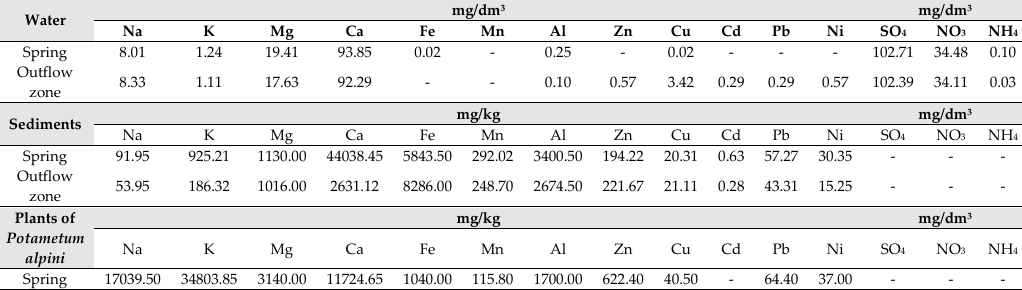
Figure 6. Ratio of water macroelement concentrations in the water source zone to those in the outflow zone. Table 2. Chemical parameters of habitat of Potametum alpini Podbielkowski patches. Table 2. Chemical parameters of habitat of Potametum alpini Podbielkowski